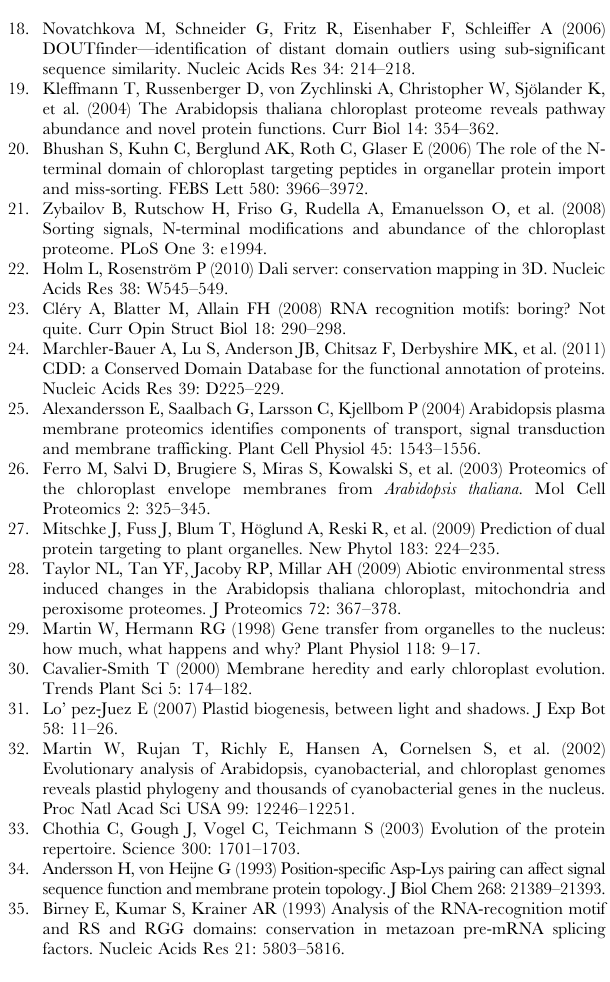
Figure S1 Multiple sequence alignment of plant ERD4 and proteins of animalia (taxid:33208) kingdom identi- fied by BLAST. The alignment of plant ERD4 sequences [ B. juncea (UniProtKB, A9LIW2) and A. thaliana (UniProtKB,